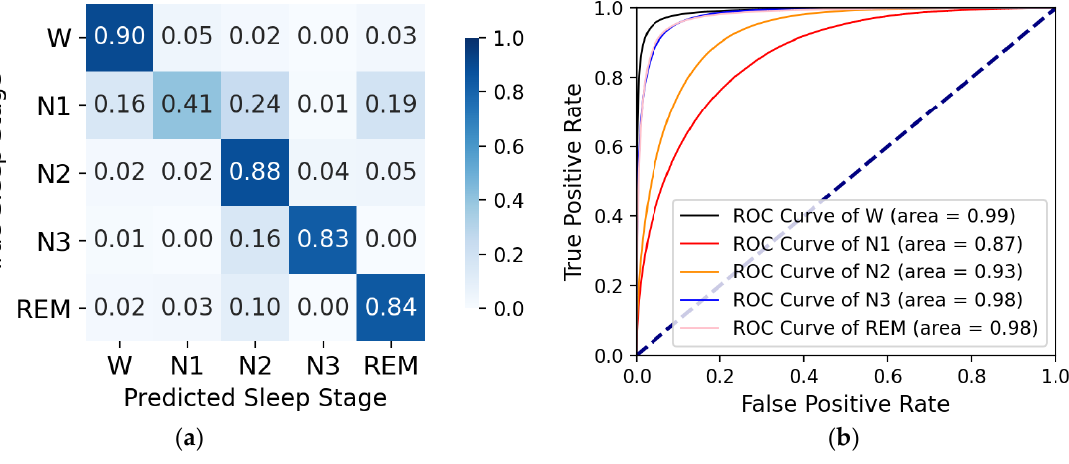
Figure 4. The CAttSleepNet model ’ s confusion matrix and ROC curve are obtained from the Fpz-Cz channel of the sleep-edfx-2013 dataset. ( a ) Confusion matrix; ( b ) ROC curve.